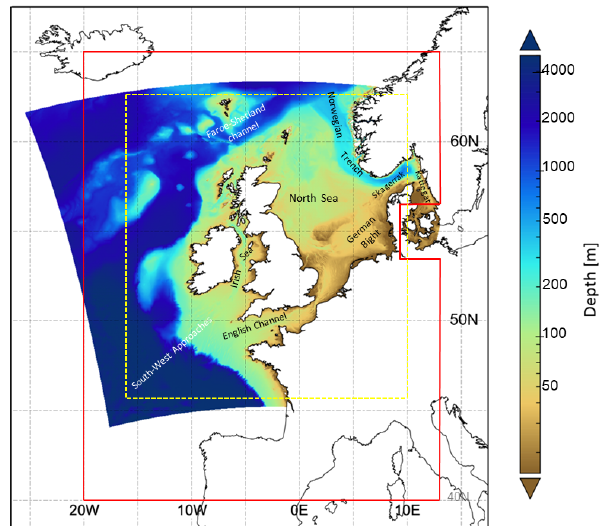
Figure 1. European Marine Observation and Data Network (EMODnet bathymetry, in metres (logarithmic scale), showing the NWS high-resolution AMM15 model domain. The red line defines the NWS low-resolution AMM7 model domain. The yellow dotted box is the domain covered by the AMM15 products delivered on a regular grid to the Copernicus users. Figure is modified from Gra- ham et al. (2018b). The bathymetry colour range has a logarithmic